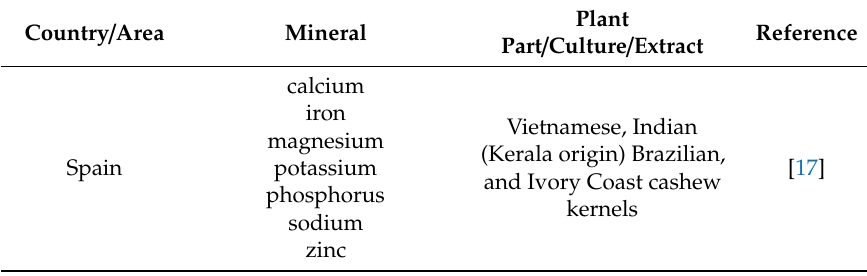
Table 3. Mineral composition in Anacardium